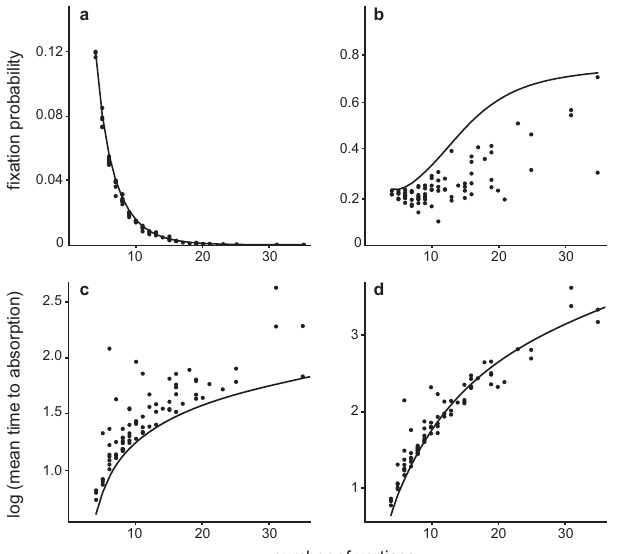
Figure 4. Fixation probabilities and mean times to absorption for a single Dove invader. The Hawk-Dove game is played with a background fitness of F of the resource of B = 5. Costs for loosing a fight are (a, c) C = 2 and (b, d) C = 13. Dots give mean values for 10,000 simulations for each of the 81 primate graphs and the solid line gives the expected value for a well mixed population.